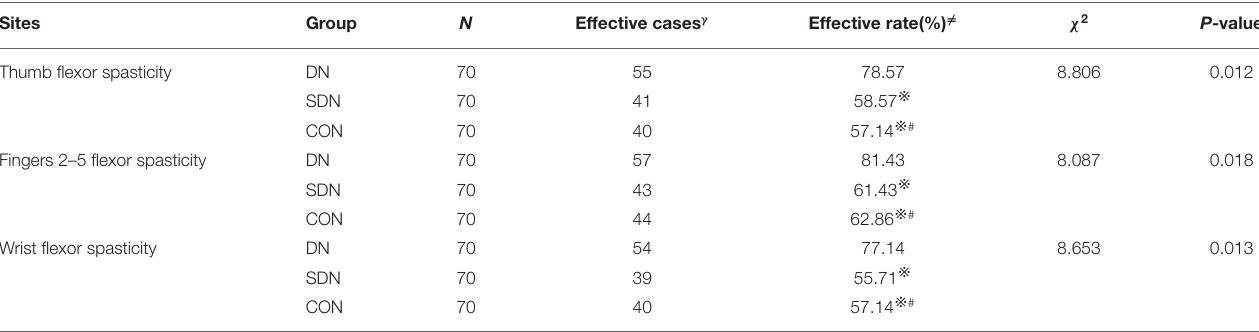
TABLE 7 | Effective rate of spasticity relief from baseline to week 4. Sites Thumb flexor spasticity